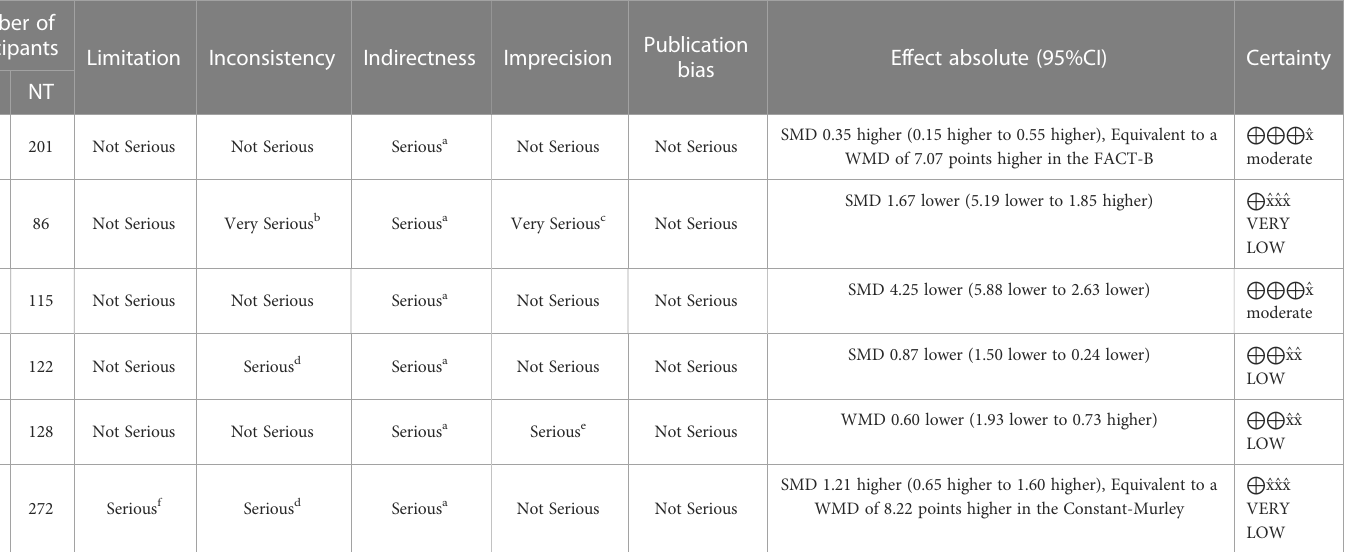
TABLE 1 GRADE evidence pro fi le of outcomes — summary of fi nding table of TCC-based exercise vs. non-TCC interventions for breast